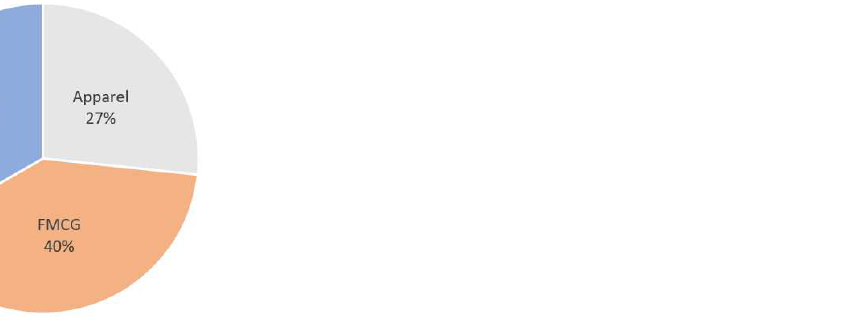
Figure 5. Percentage distribution of category II respondents by retail industry type.